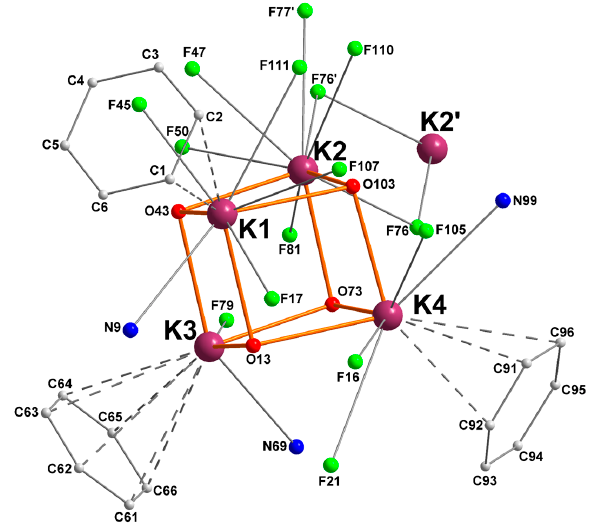
Figure 2. Simplified representation of the molecular solid-state structure of complex [{RO 1 }K] 4 ([ 1 ] 4 ). Color code: purple, K; green, F; blue, N; red, O; grey, C. Hydrogen atoms are omitted for clarity. Only the heteroatoms and aryl substituents interacting with potassium are depicted.